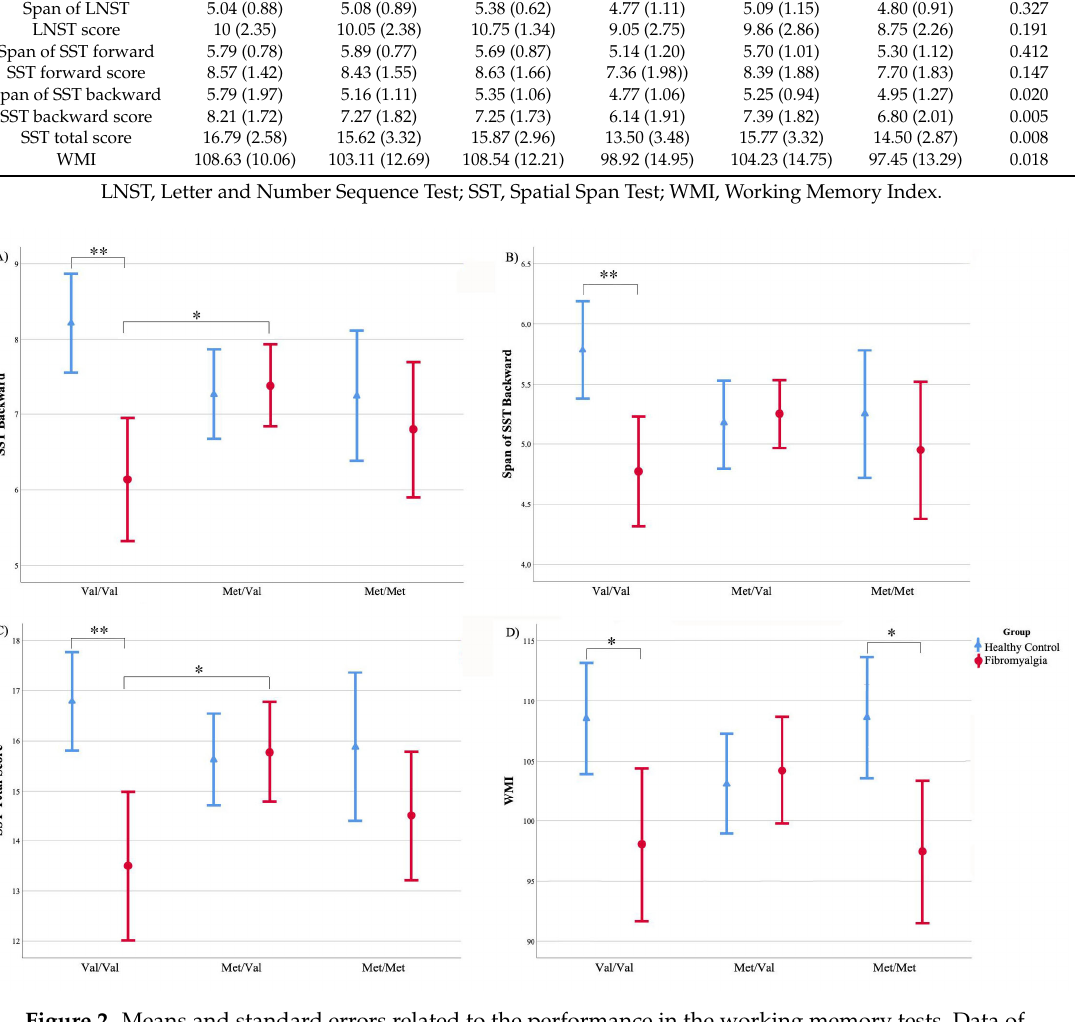
COMT p -ValueHealthy Control